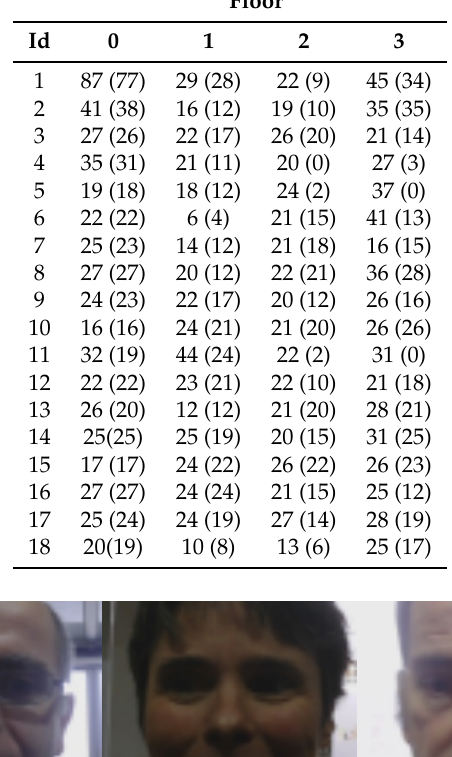
Table 1. Dataset distribution of samples per identity and floor (in brackets, the final number of detected faces per identity and floor).